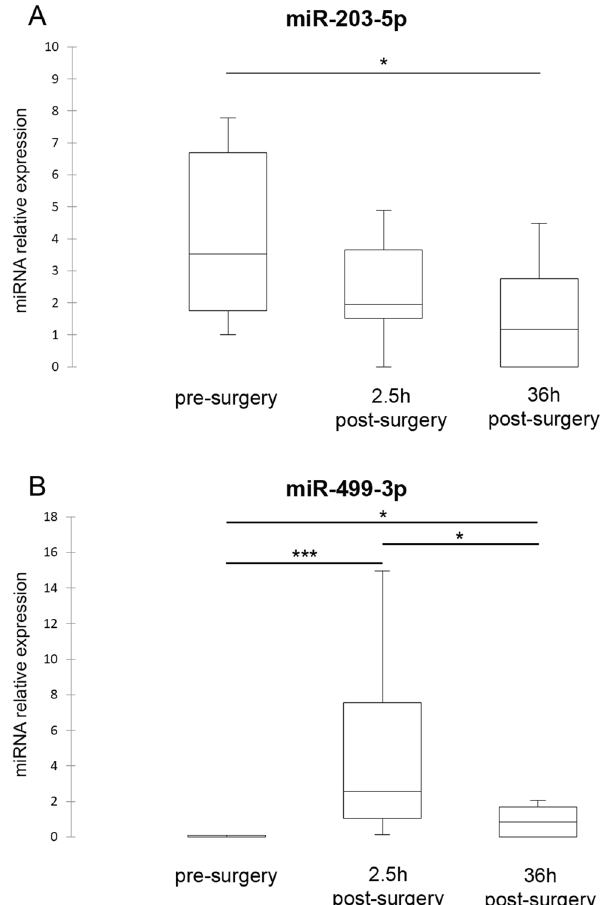
Figure 2. Box plots of DE-miRNAs pre- and 2.5 h and 36 h post-surgery. Significance was declared at P < 0.05 (*), P < 0.01 (**) and P < 0.001 (***). Black lines inside the boxes mark the